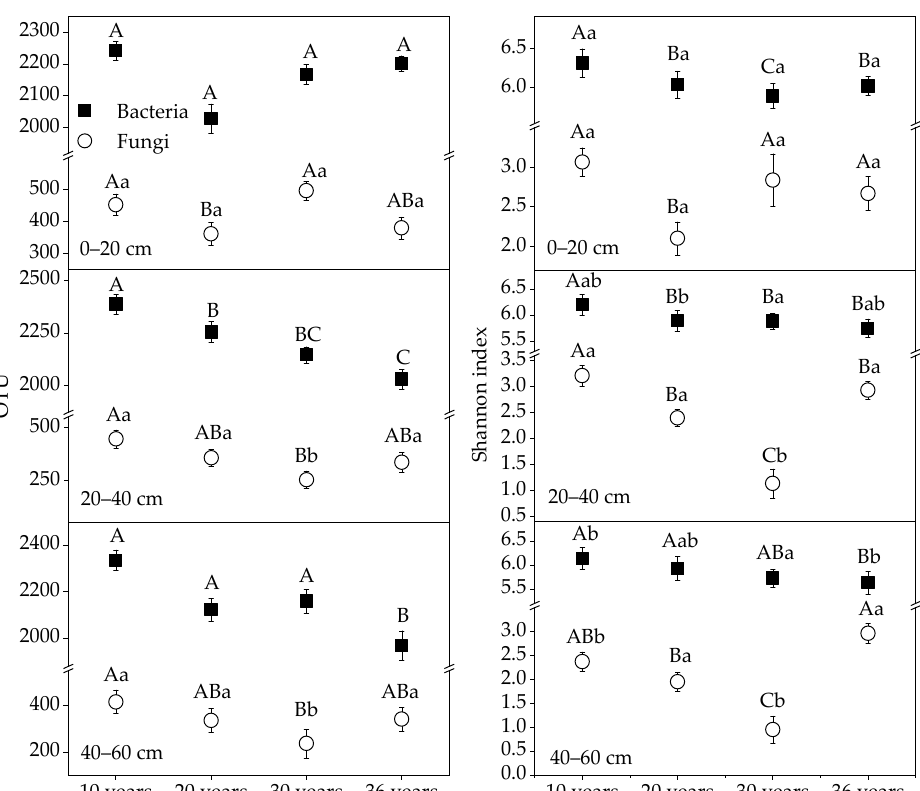
Figure 5. Alpha diversity of soil bacterial and fungal communities at different stand ages and soil depths. 0–20 cm: 0–20 cm soil depth; 20–40 cm: 20–40 cm soil depth; 40–60 cm: 40–60 cm soil depth. The values show means ± SE. Different capital and lowercase letters represent differences among different stand ages and soil depths, respectively ( p < 0.05).